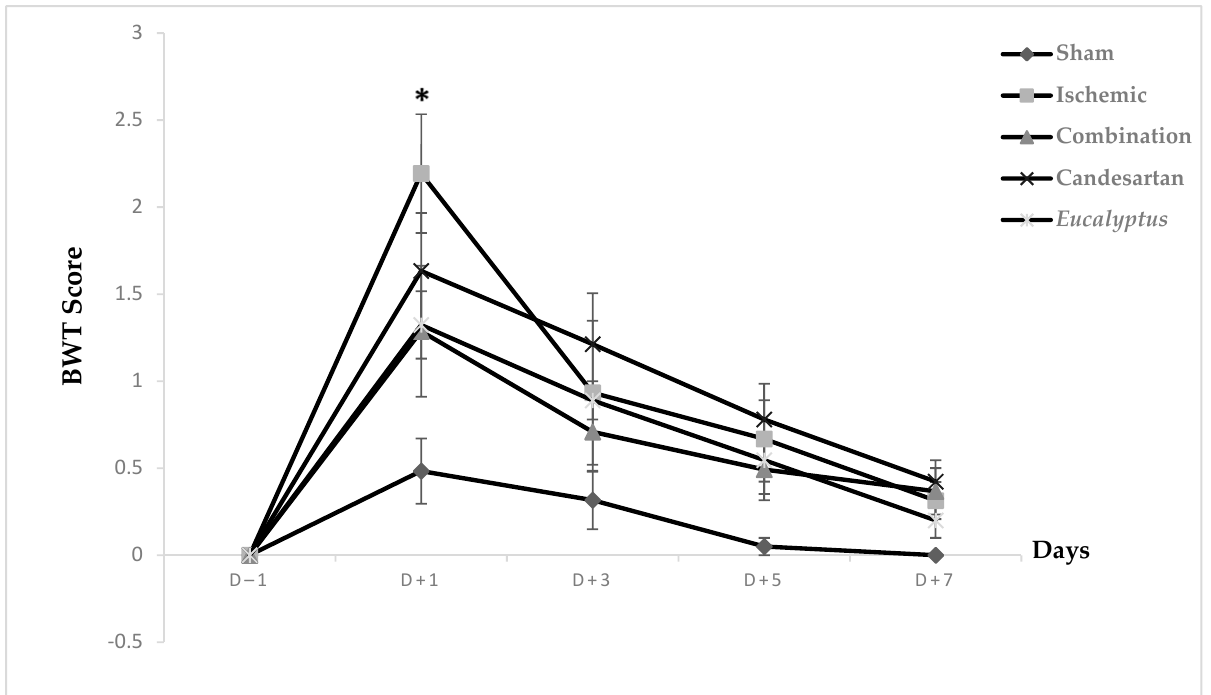
Figure 2. Beam walking test (BWT) scores. BWT results showing the average score on days ( − 1, +1, +3, +5, +7) for Sham (n = 6), Ischemic (n = 11), Ischemic treated with a combination of Candesartan and Eucalyptus (n = 10), Ischemic treated with Candesartan (n = 5), and Ischemic treated with Eucalyptus (n = 5) groups. * p < 0.05 for a significant difference between Ischemic and Sham groups.